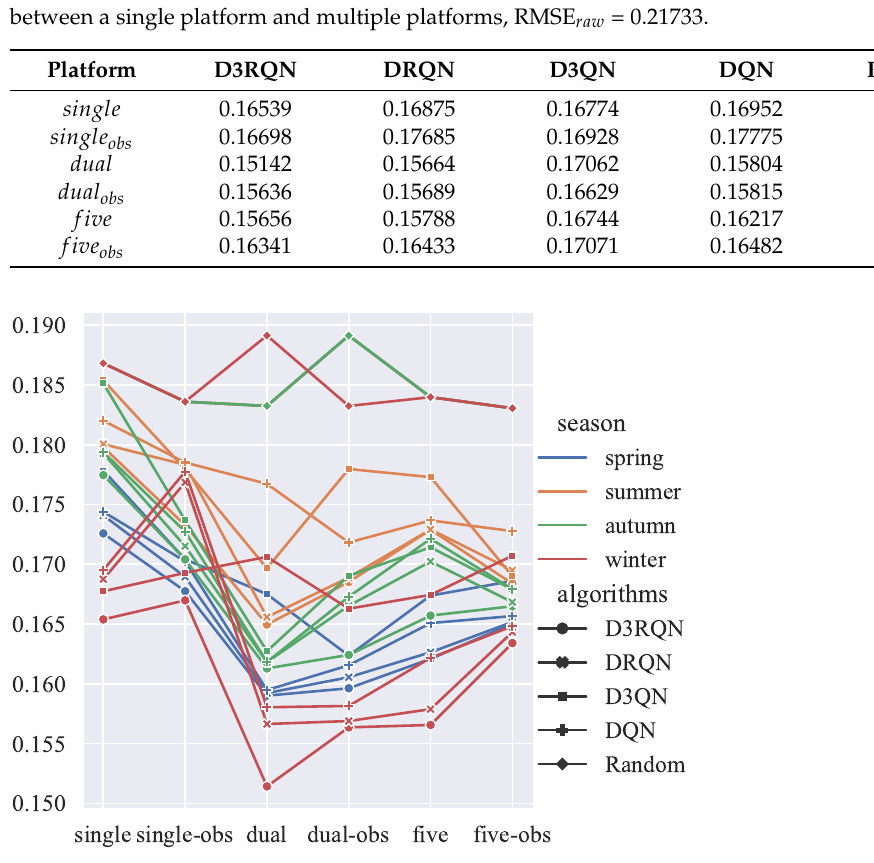
Figure 9. RMSE comparison chart of different algorithms in four